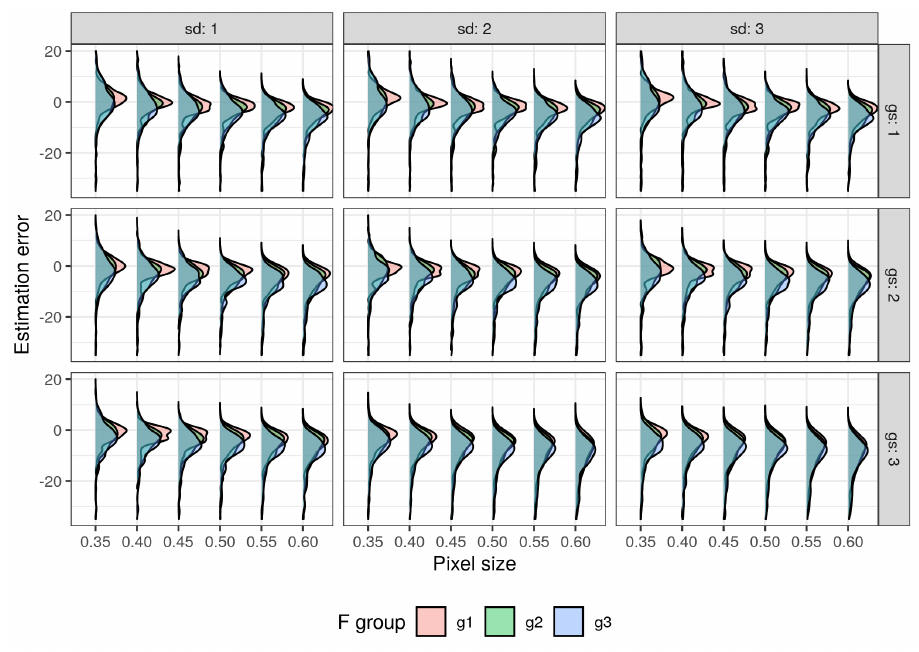
Figure 11. Distribution of estimation error of number of trees on sample plots in F category groups (crown visibility ratio—ratio of partial visible crowns of trees to fully visible crowns of trees—g1: less than 10%, g2: between 10% and 20%, and g3: over 20%) dependent on Watershed method parameterization—Canopy Height Model (CHM) spatial resolution (pixel size in meters), Gaussian smoothing strength (Gaussian filter window size (gs) and standard deviation (sd) in pixels).